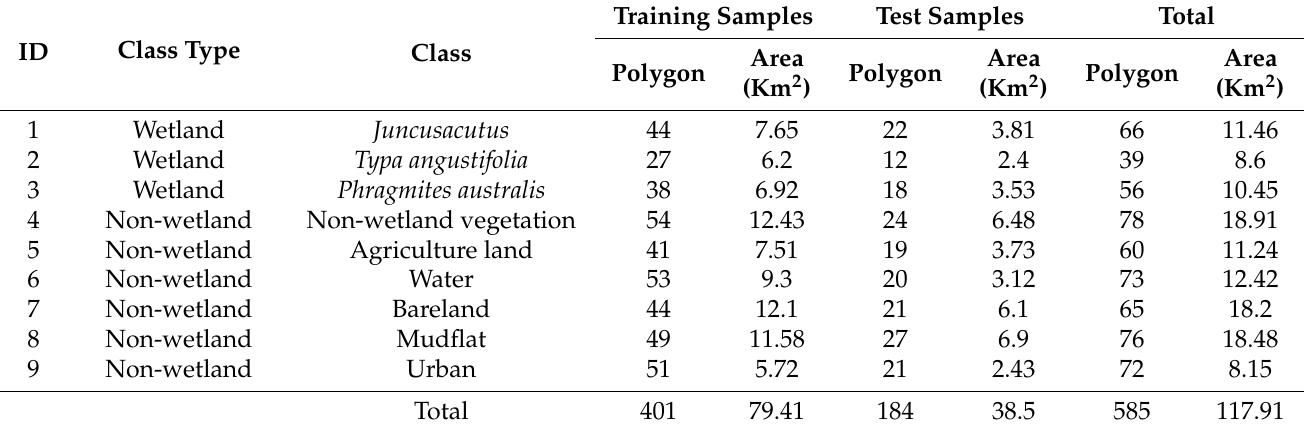
Table 1. The number and area of the training and test polygons across the study area.